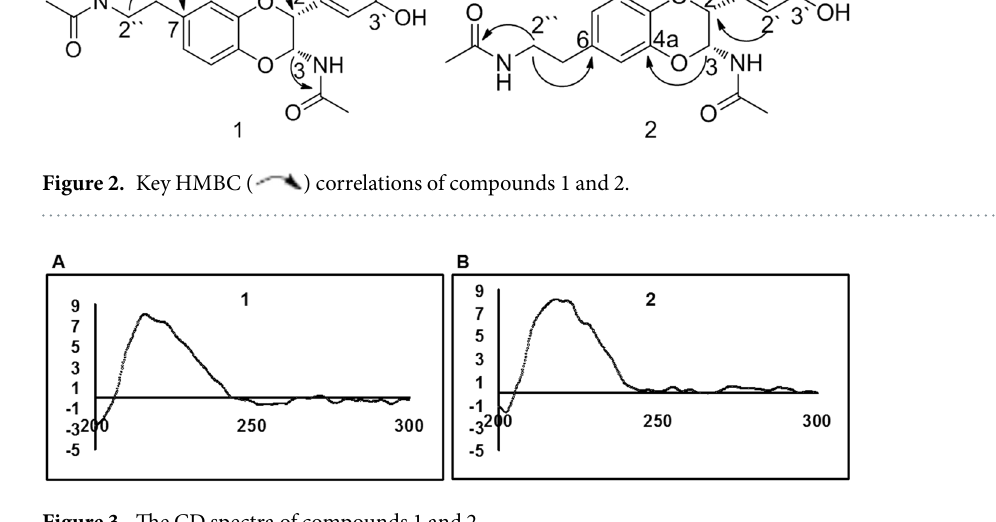
Figure 3. The CD spectra of compounds 1 and